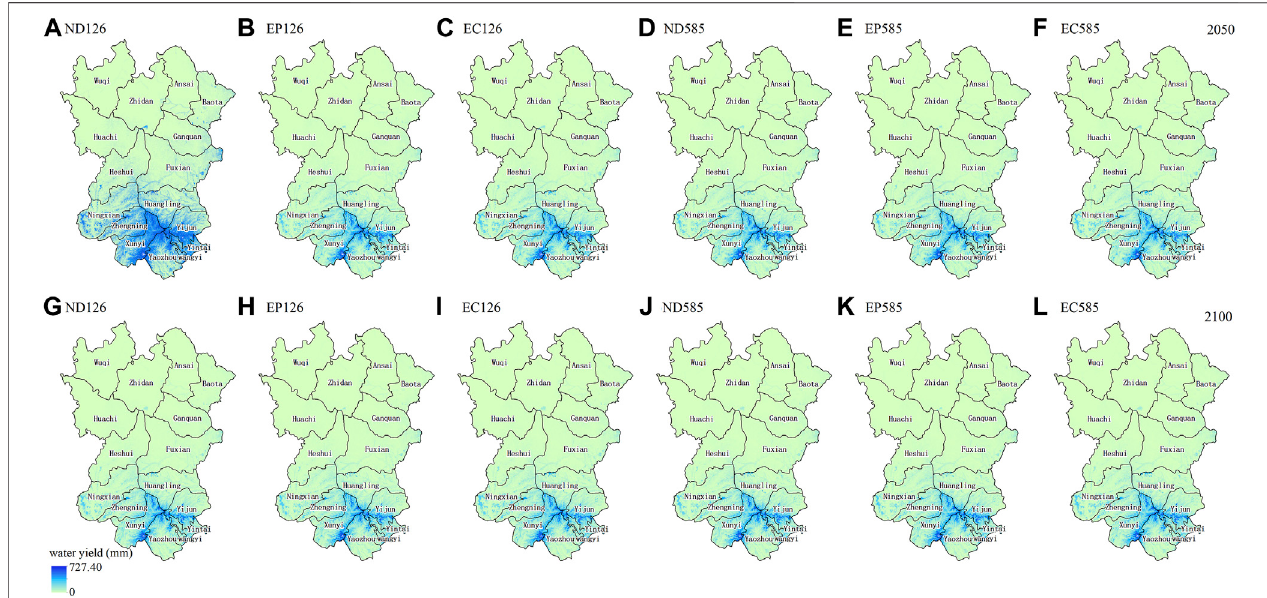
FIGURE 5| Spatial variation in water yield service in the ZMR under different scenarios in 2050 (A – F) and 2100 (G – L) . Note: ND-the natural development scenario of land use, EP-the ecological protection scenario of land use, EC-the economic construction scenario of land use, 126-climate paths SSP1-2.6, 585-climate paths